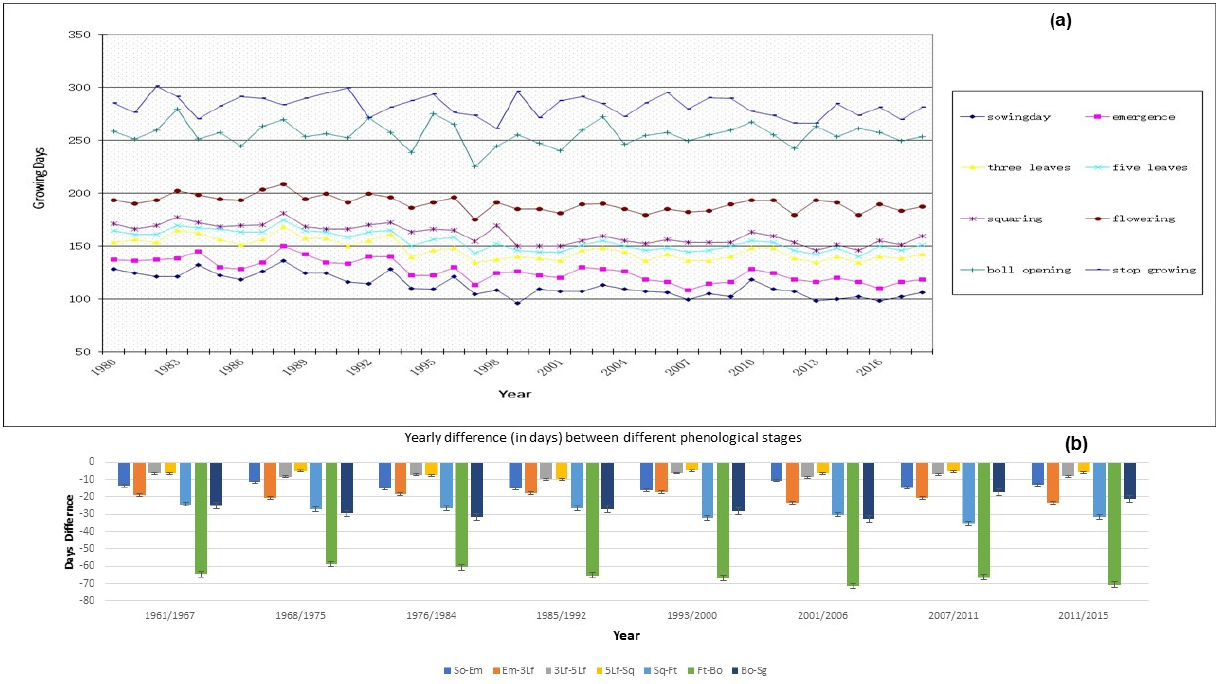
Figure 4. CHCN simulation of observed data of annual mean temperature (°C) effect on variation in the length of cotton harvesting time in Xinjiang during 1980–2018 ( p = 0.39).